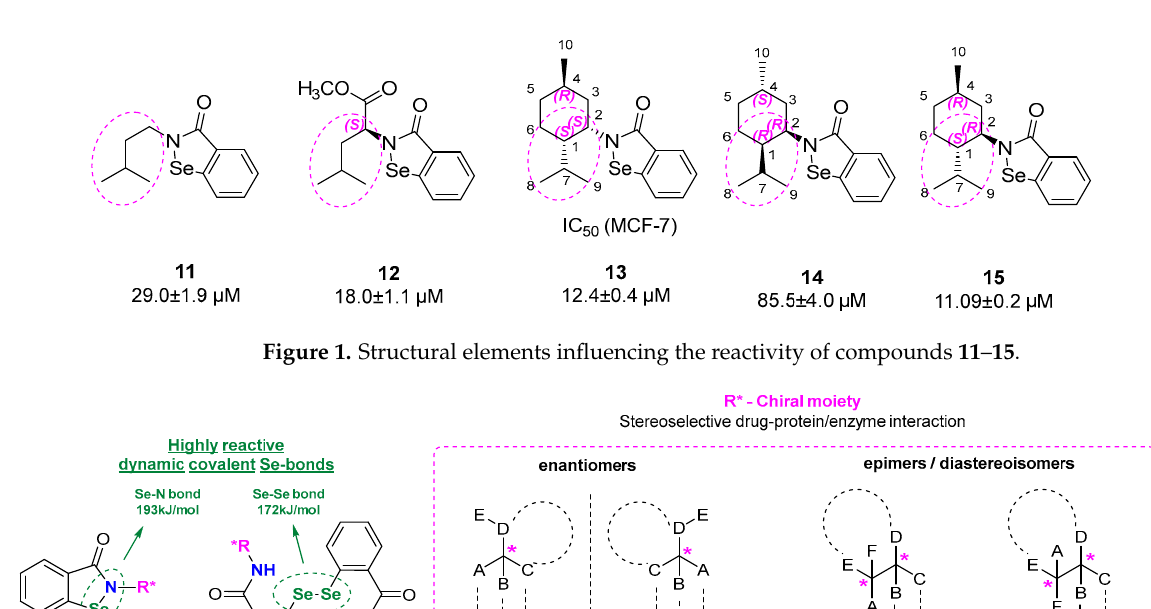
Figure 1. Structural elements influencing the reactivity of compounds 11 – 15 .